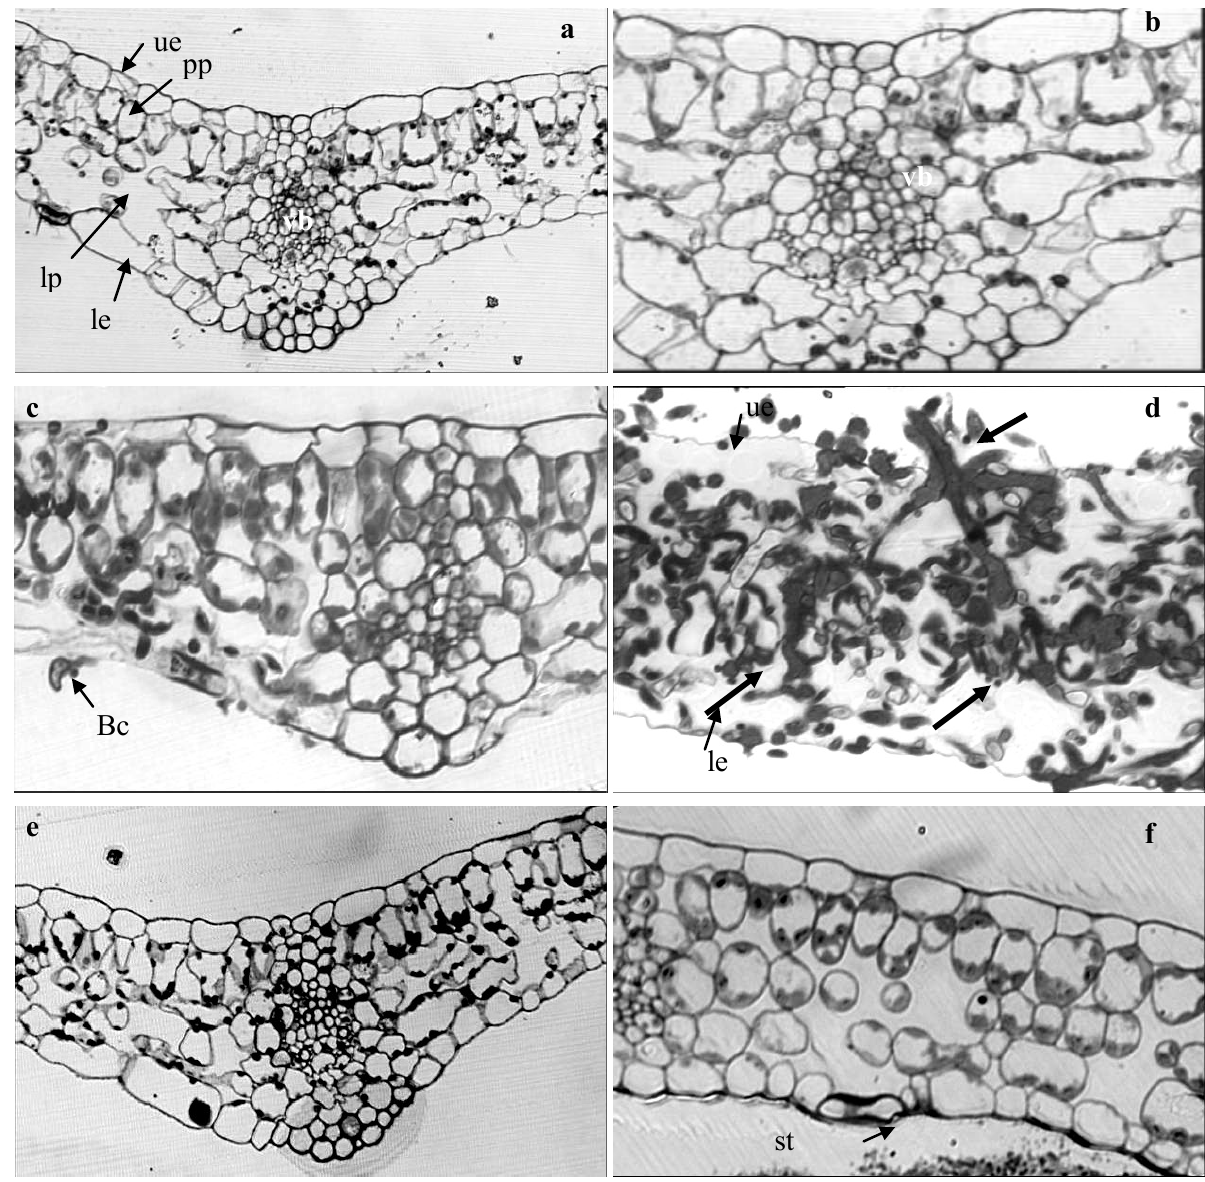
Figure 4. Light micrographs of samples from grapevine leaves. ( a , b ): non-treated leaves with healthy tissues. ( c , d ): leaves inoculated with B. cinerea. Fungal growth occured intra- and inter-cellularly (arrows), inducing a complete cell and tissues disorganization. ( e , f ): leaves of grapevine previously treated with a suspension of U. atrum isolates, U13 ( e ) or U16 ( f ) before being treated with B. cinerea . The pathogen growth fails and was stopped by the antagonists. Bc: B. cinerea ; le: lower epidermis; lp: lacunous parenchyma; pp: palisadic parenchyma; st: stomata; ue: upper epidermis; vb: vascular bundle. Magnification for panels a , e , and f , ×20; magnification for panels b , c , and f ,